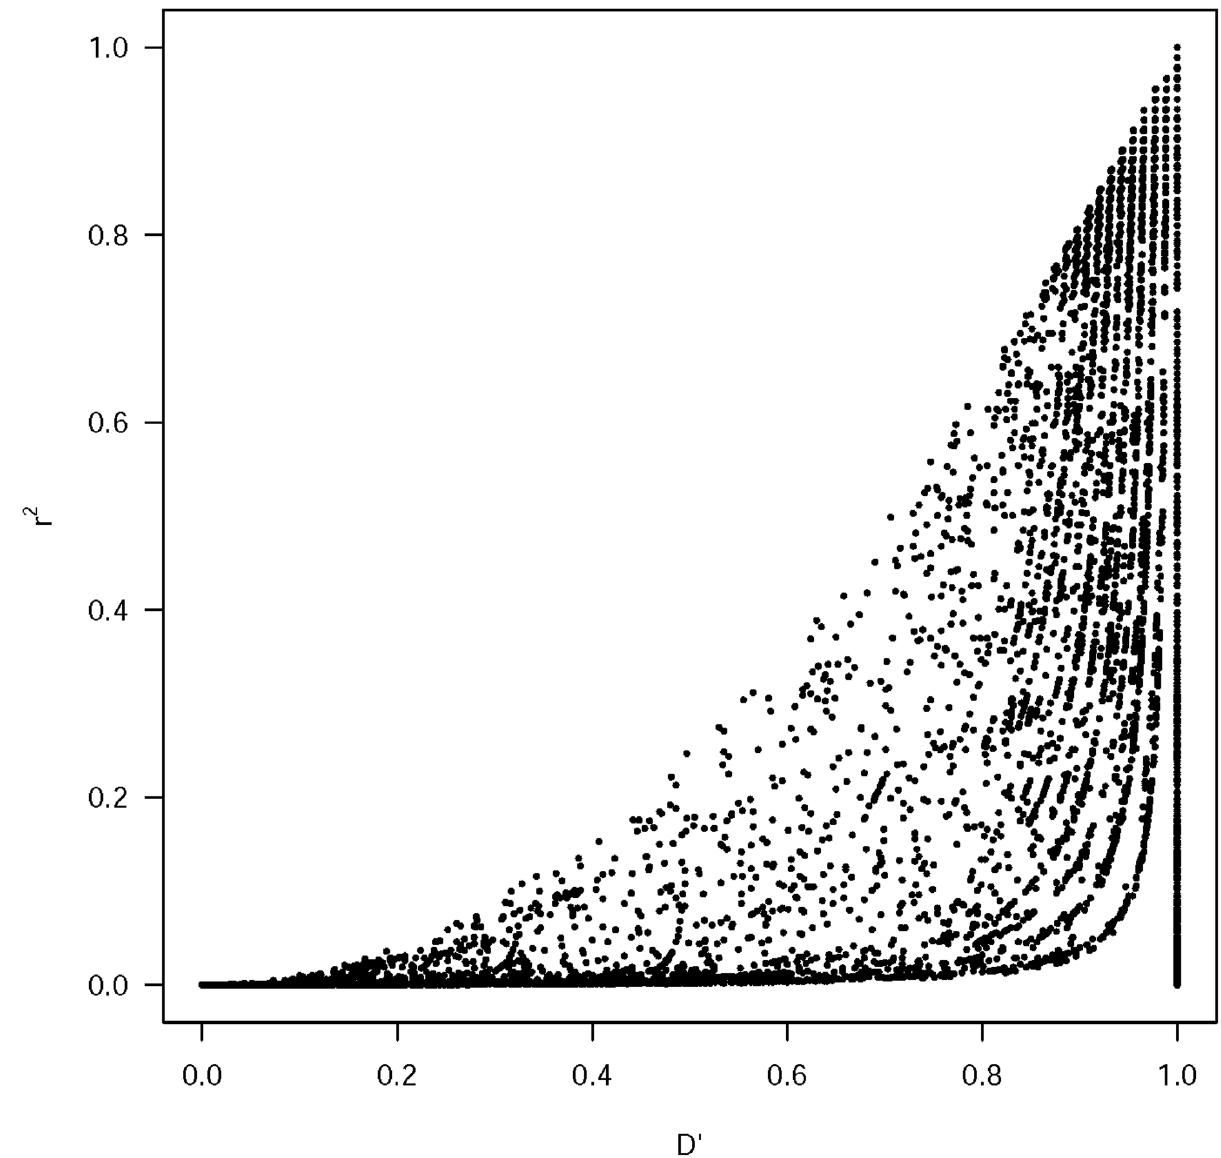
Fig 5. Intra-chromosal decay of linkage disequilibrium (r 2 ) as a funcion of genetic distance (cM) (a) across genepools, (b) within the Andean genepool, and (c) within the Mesoamerican genepool. Exponential tendency lines are shown when